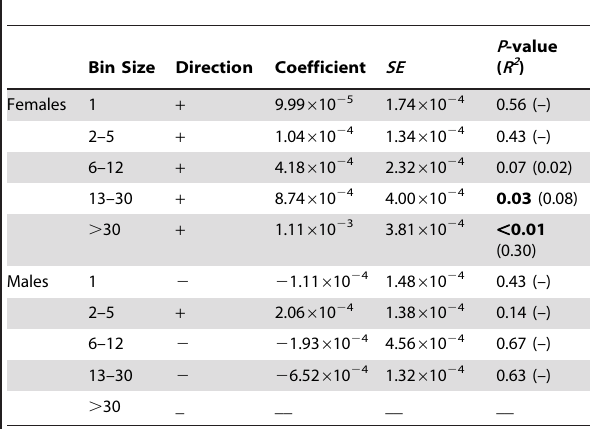
Table 3. Regression of daily probability of encounter with groups (binned by size) as a function of population size for elk in Riding Mountain National Park (2002–2004, 2007–2009).